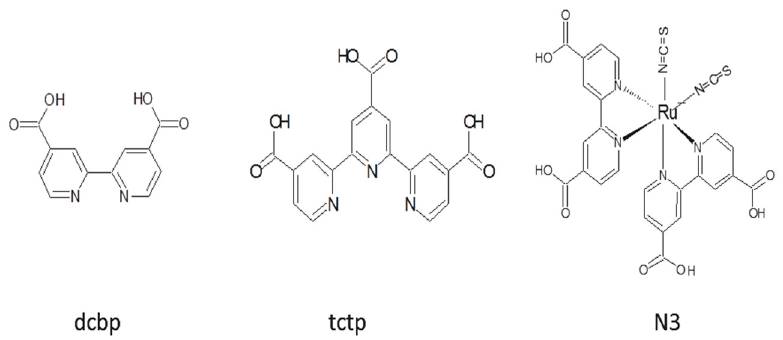
Figure 35. Dcbp, tctp, and N3 dye.